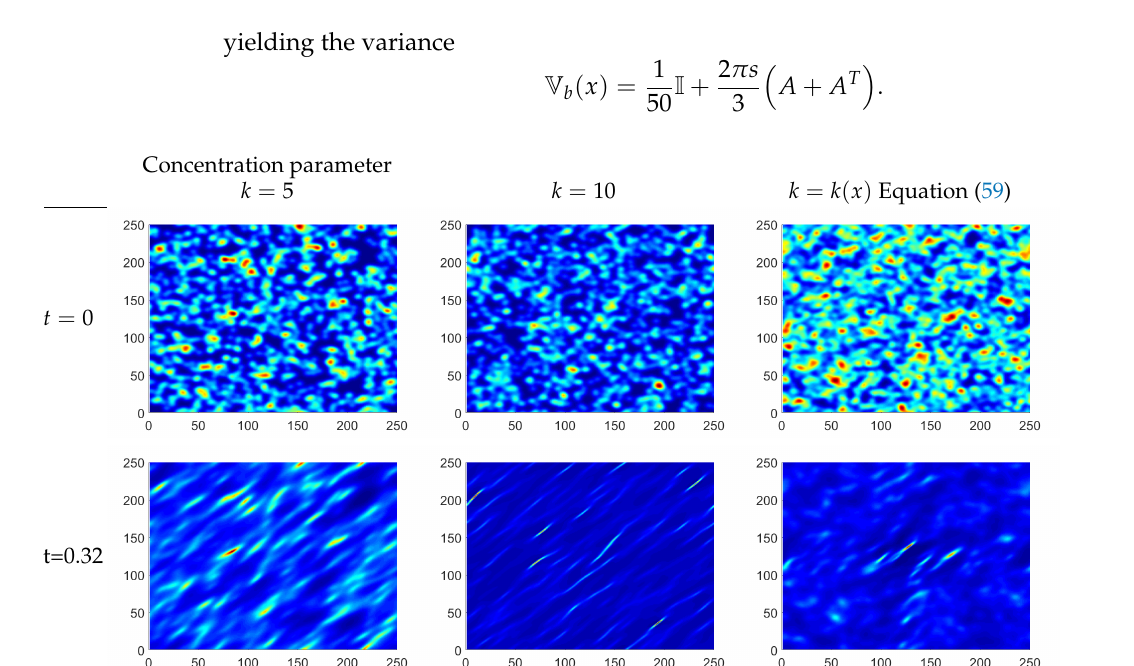
Figure 4. Inclusion of anisotropy for different values of the concentration parameter k . Cell densities are shown at time t = 0 (first row) and time t = 0.32 (second row), where the total cell density is 200 cells/mm 2 in each of the plots.